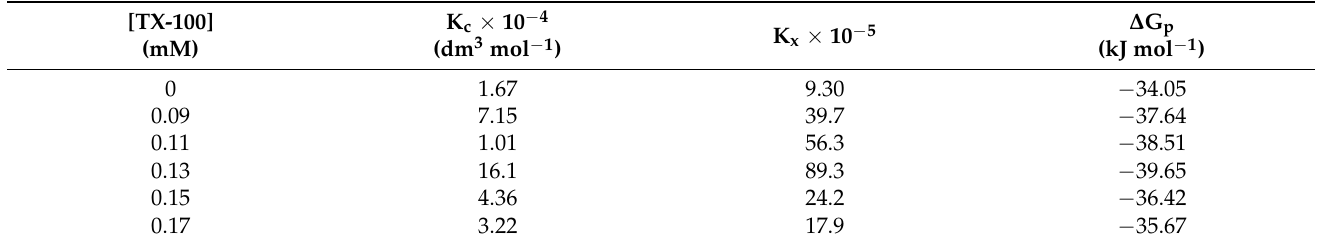
Figure 3. ( a ) Calculation of partition constant, K x by Kawamura equation, for NGB-CTAB, ( b ) calculation of partition constant, K x by Kawamura equation, for NGB-CPC. Table 1. Gibbs energy of partition ∆ G p , partition coefficient, K x partition constant, K c , for NGB/CTAB systems at various Triton X-100 concentrations.